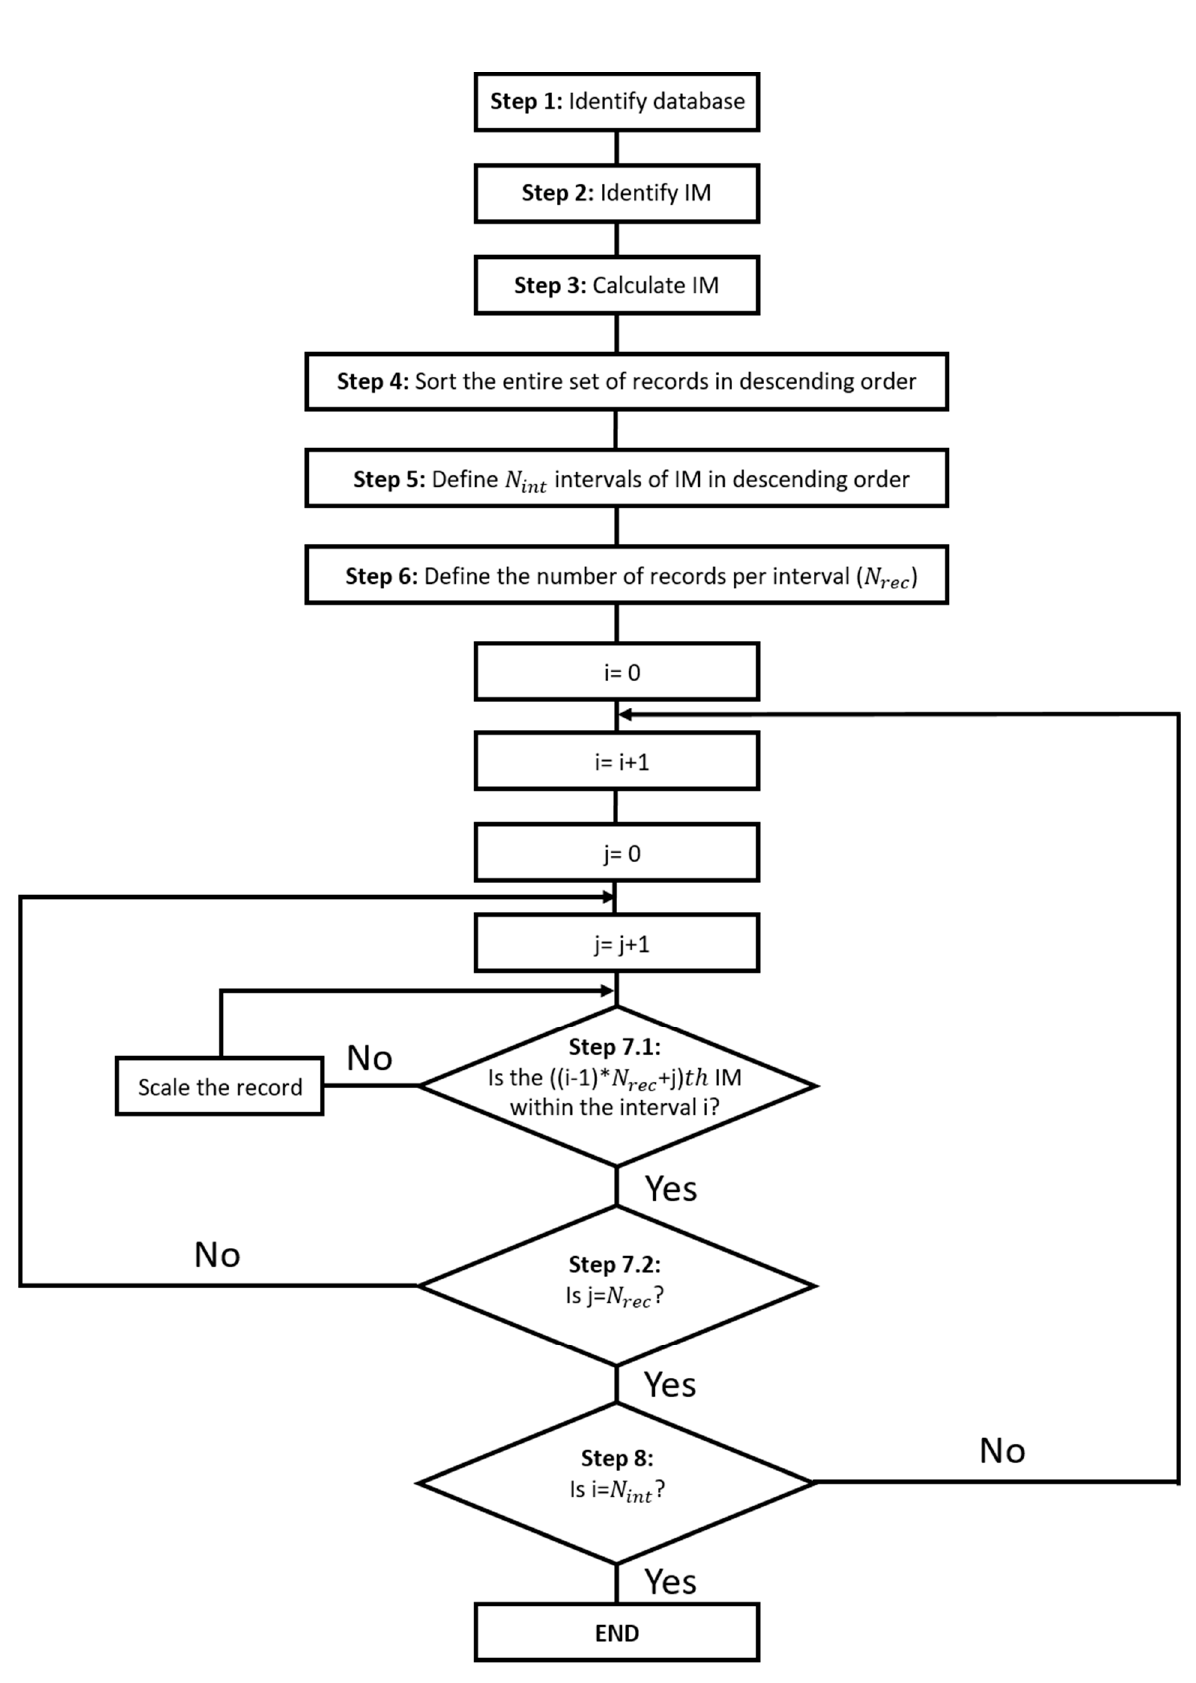
Figure 4. Flowchart illustrating the main steps for selecting and scaling ground motion records.